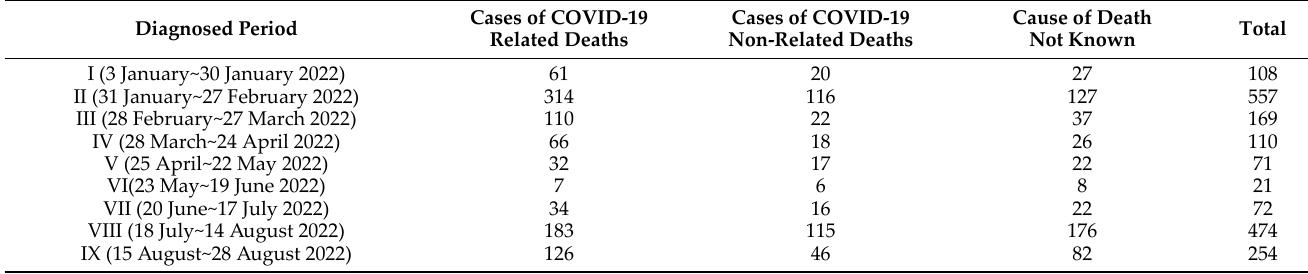
Table A3. Fatality rates of COVID-19 cases caused by one of three sublineages of the Omicron variant in Japan, 2022 (40s, 50s, 60s, 70s and ≧ 80 years).